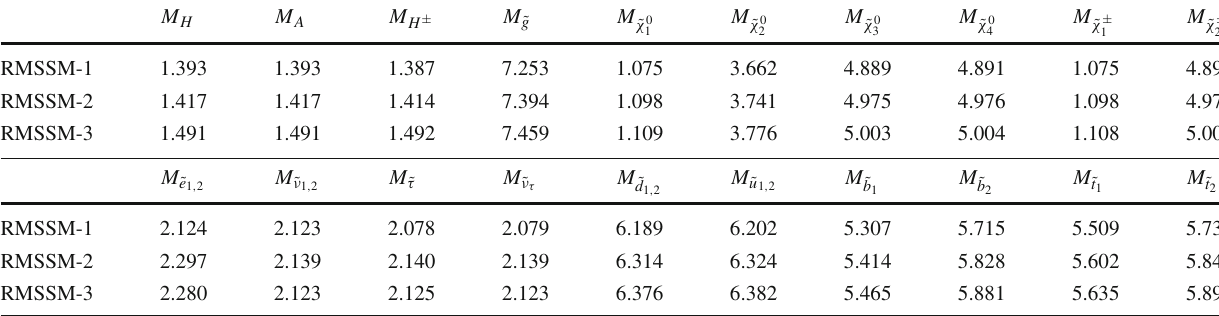
Table 11 Masses for each benchmark of the reduced MSSM (in